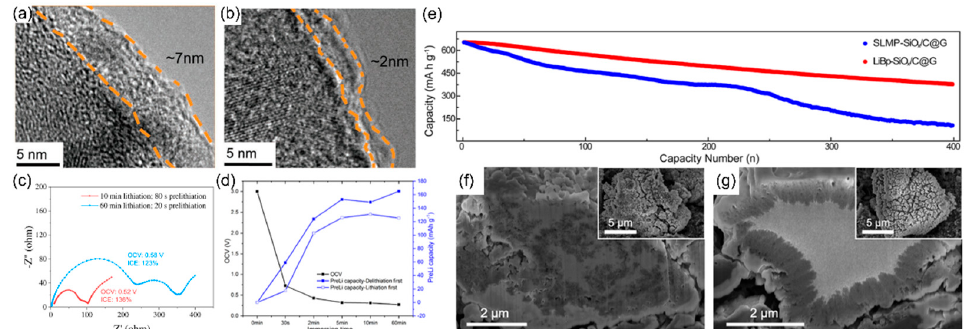
Figure 6. TEM images of ( a ) pristine hard carbon anode and ( b ) prelithiated hard carbon anode after initial cycle. Reproduced with permission from ref. [41]. Copyright 2020, Wiley-VCH. ( c ) Electro- chemical impedance spectra of two half-cells assembled with hard carbon anodes prelithiated by Li-DMBP (10 min) and Li-DMBP (60 min), with a similar degree of prelithiation. Reproduced with permission from ref. [54]. Copyright 2021, ACS Publications. ( d ) OCV values and prelithiation ca-